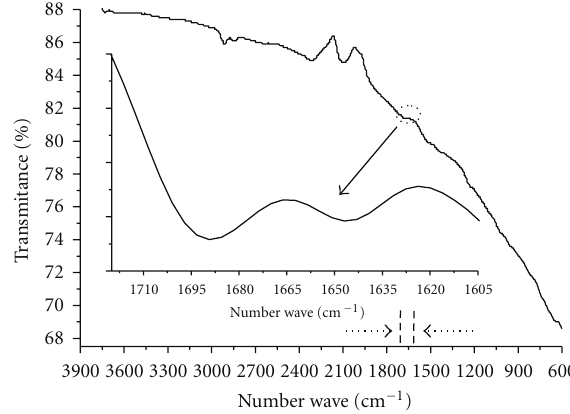
Figure 11: FT IR image of carbon nanotubes of first isothermal